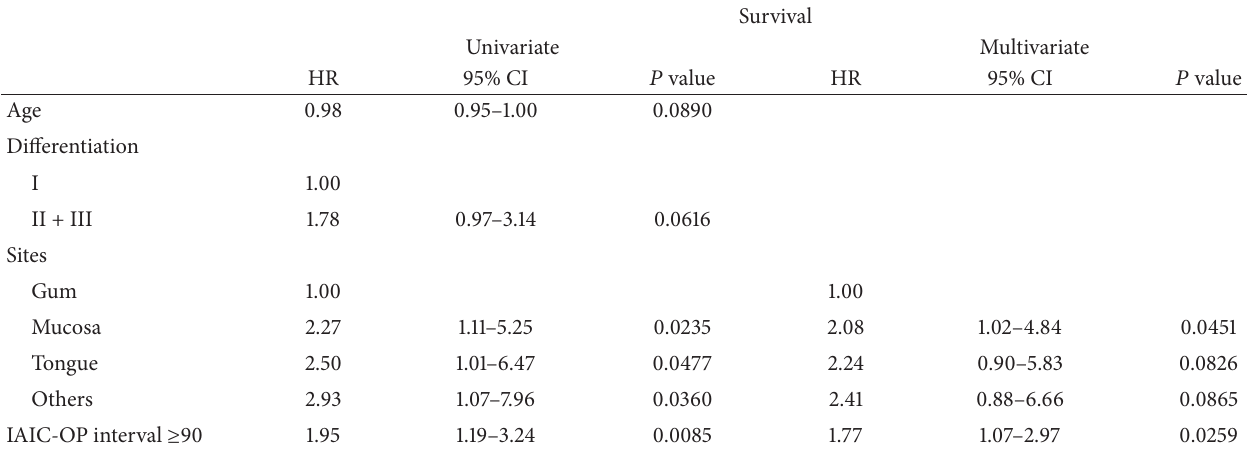
Table 3: Univariate and multivariate analysis of prognostic factors in locally advanced OSCC receiving neoadjuvant